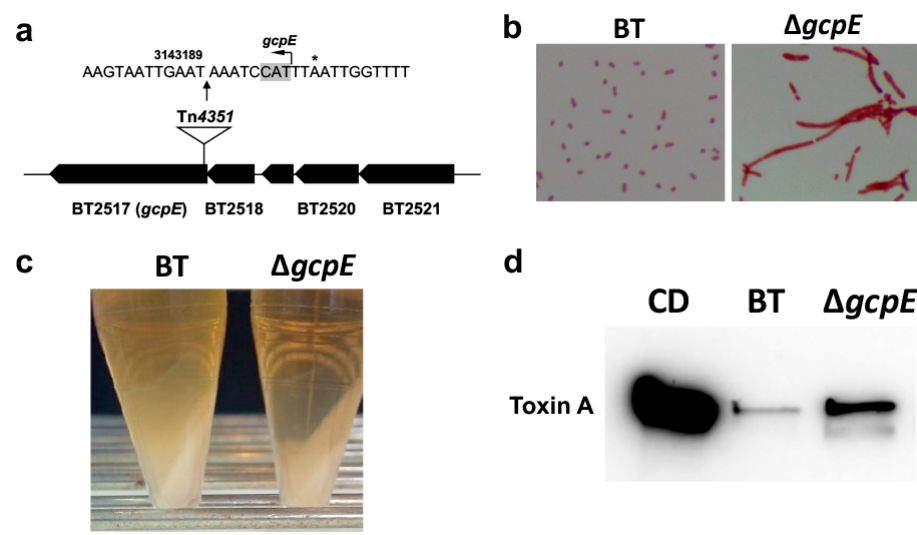
Figure 3. Characterization of the Δ gcpE mutant strain. (a) The Tn 4351 insertion site in the Δ gcpE mutant. Tn 4351 was inserted into the 5 ′ end of gcpE . *Stop codon of the upstream gene